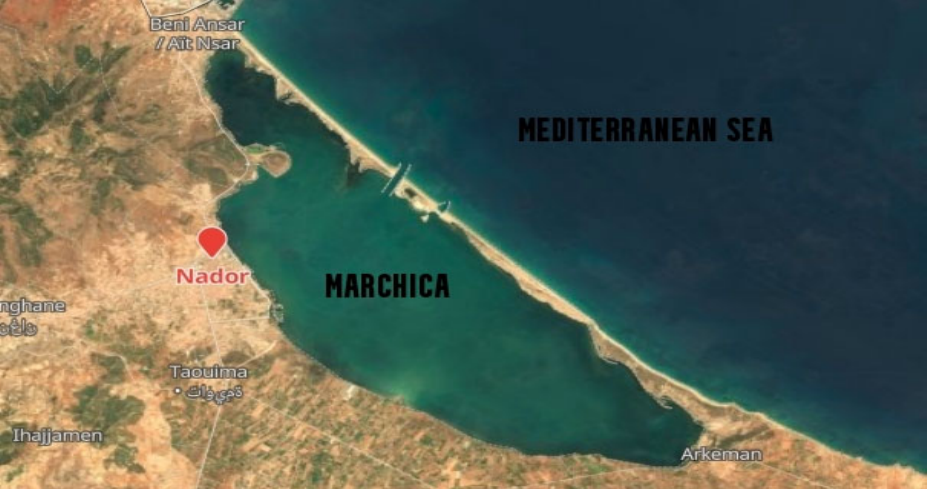
Figure 1. Marchica lagoon, North East of Morocco (N 35.11562, W 2.52803), (Image GeoEye from Google Earth, 2022).